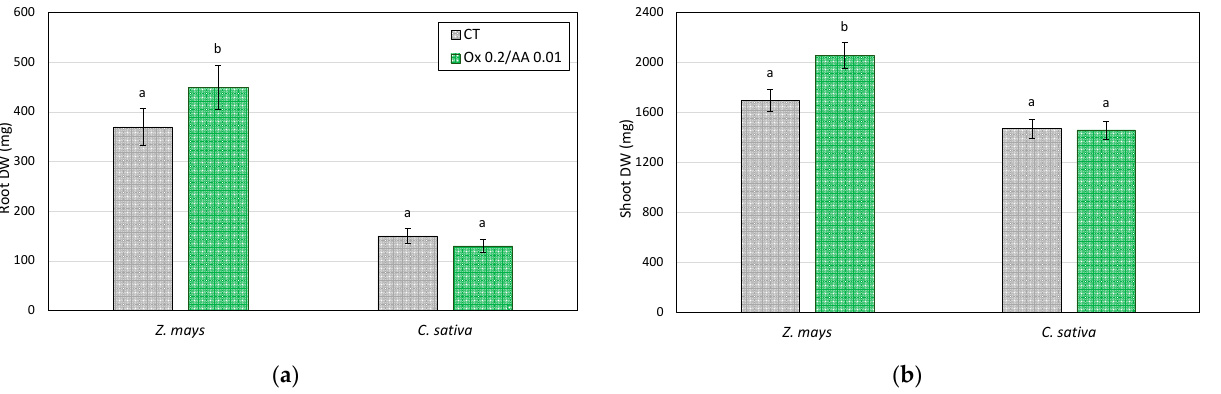
Figure 5. Dry weights (mg pot − 1 ) of ( a ) roots and ( b ) shoots of Z. mays and C. sativa grown on soil control (CT) and soils treated with the 0.2 M oxalate and 0.01 M ascorbic acid solution (mesocosm tests). Values are the means of three replicates and the error bars show the standard deviations. Values with different letters are significantly different at the 5% probability level (Tukey’s test). Table 3. As concentrations (mg kg − 1 ) in roots and shoots of Z. mays and C. sativa grown on soil control (CT) and soils treated with the 0.2 M oxalate and 0.01 M ascorbic acid solution (mesocosm tests). The values are the means of three replicates and the error bars show ± standard deviations. The different letters within the same column represent different significance levels at p < 0.05 (Tukey’s test).